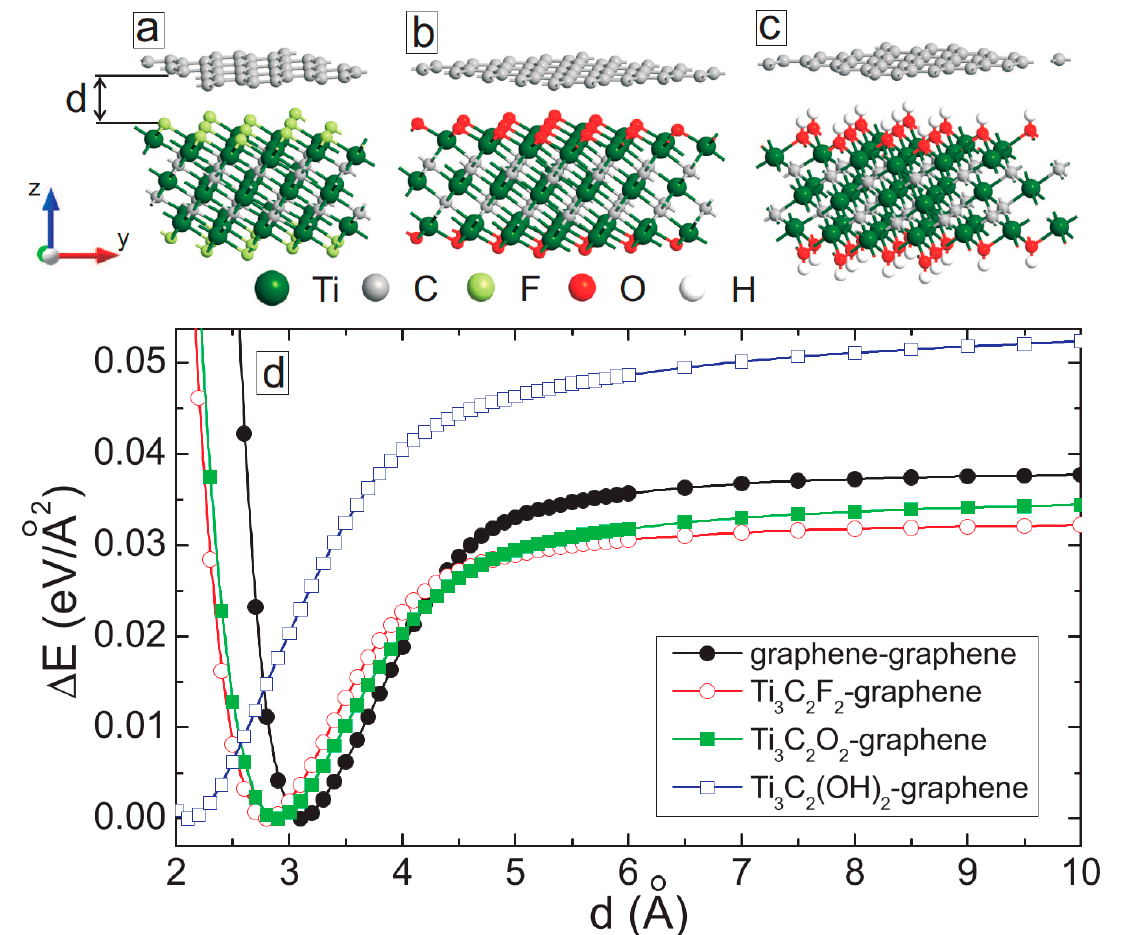
Figure 1. ( a – c ) Optimized structures of MXene/graphene bilayers with respect to the interlayer distance d . ( d ) The total energy difference of graphene/graphene and MXene/graphene samples as a function of d.